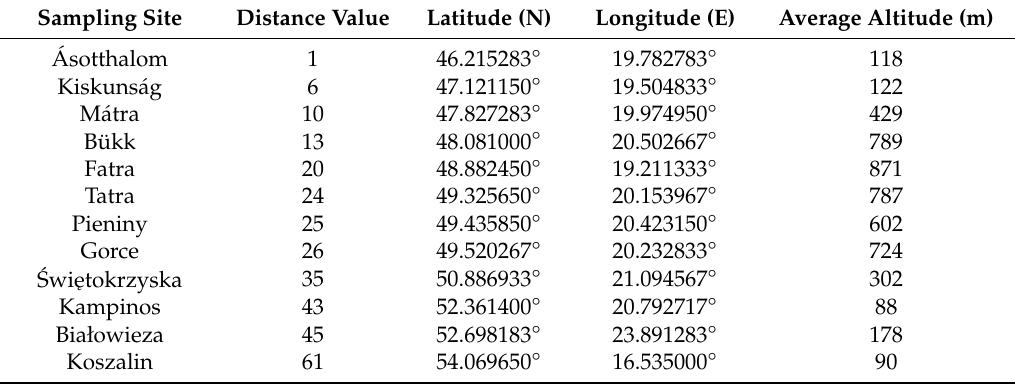
Table 1. Distance weighted numbers, coordinates, and average altitude of the sampling areas across Central Europe (Hungary, Slovakia, and